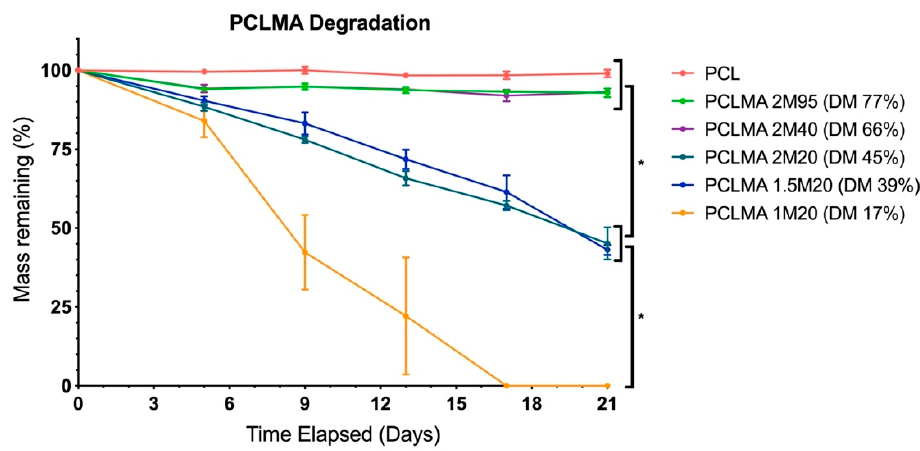
Figure 5. Accelerated degradation of PCLMA and PCL discs in 5M NaOH and the effect of degree of methacrylation. Value displayed mean ± SD, N = 1, n = 3. * denotes significant differences be ‐ tween groups at days 9, 13, 17 and 21 (two ‐ way ANOVA with Tukey’s multiple comparisons).